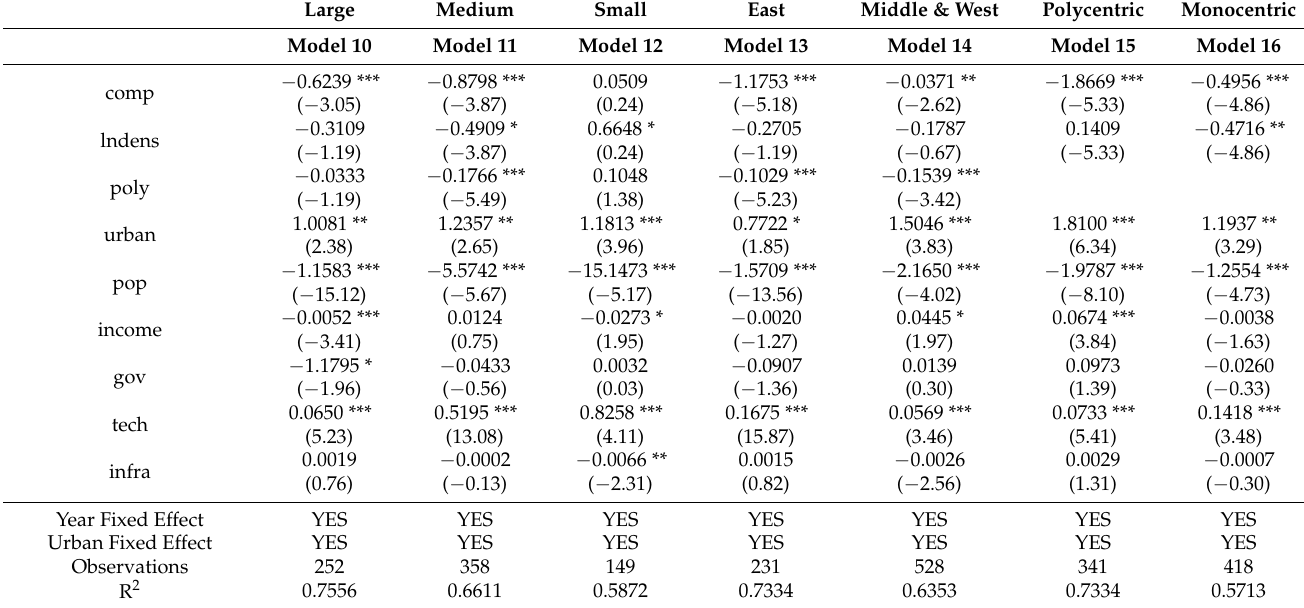
Table 5. Heterogeneity